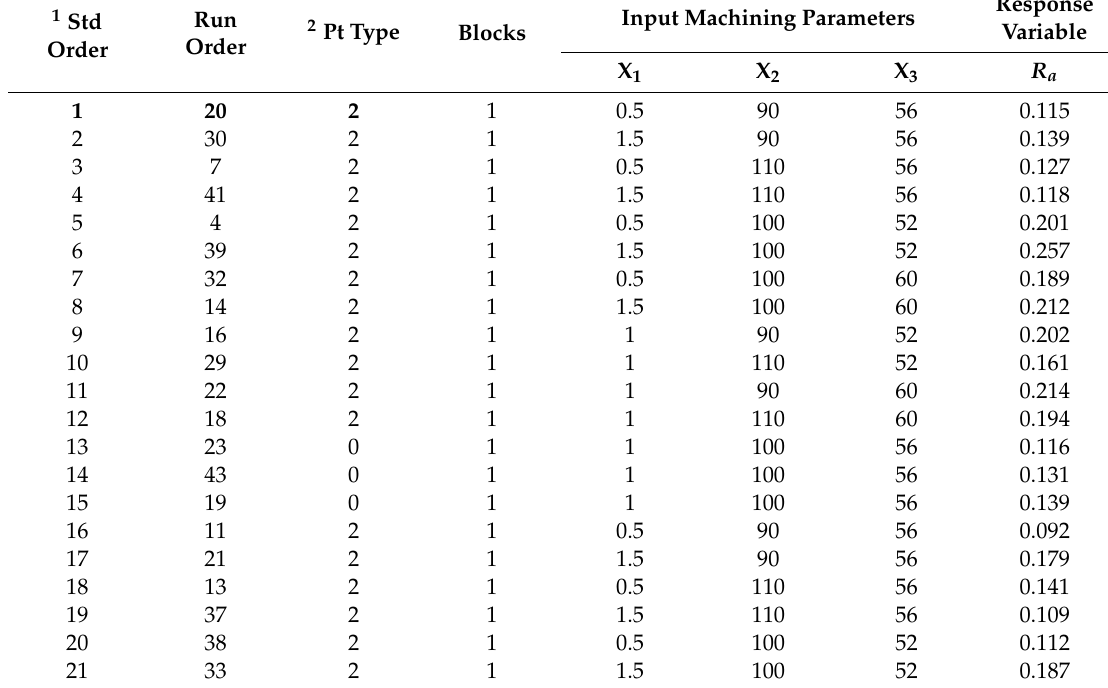
Table A1. The design of experiment with test run order and output in term of surface